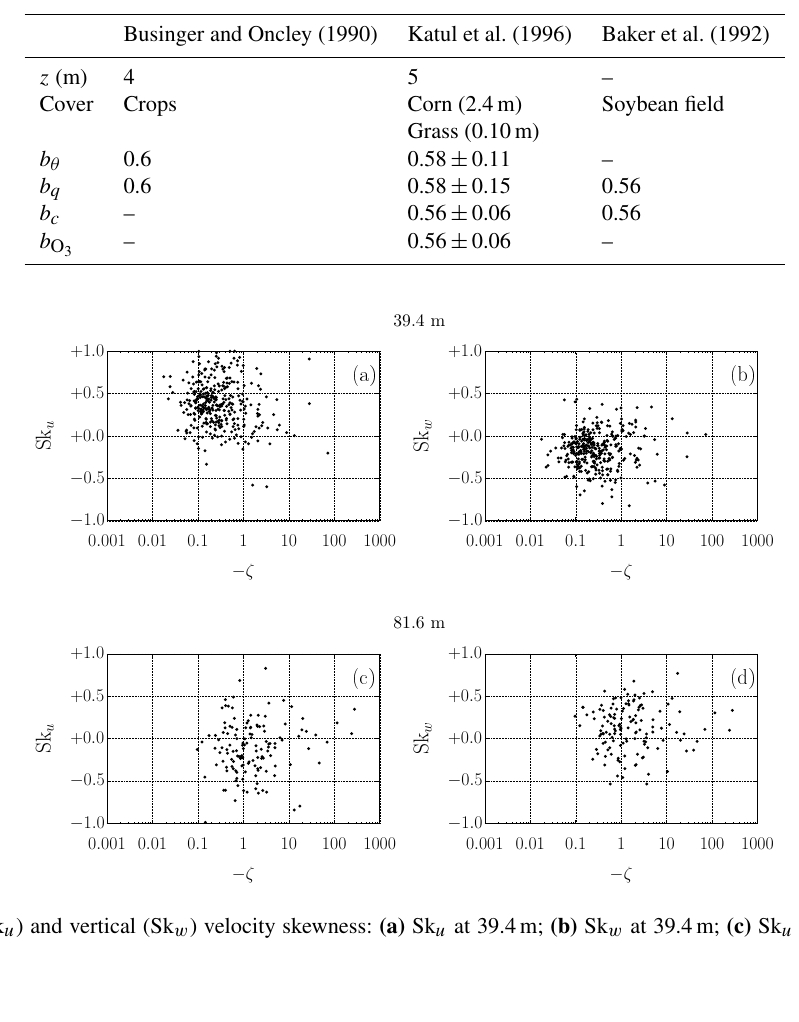
Table 1. REA coefficients measured above the roughness sublayer, where z is the measurement height (in meters) and numbers between brackets are the height of the canopies.